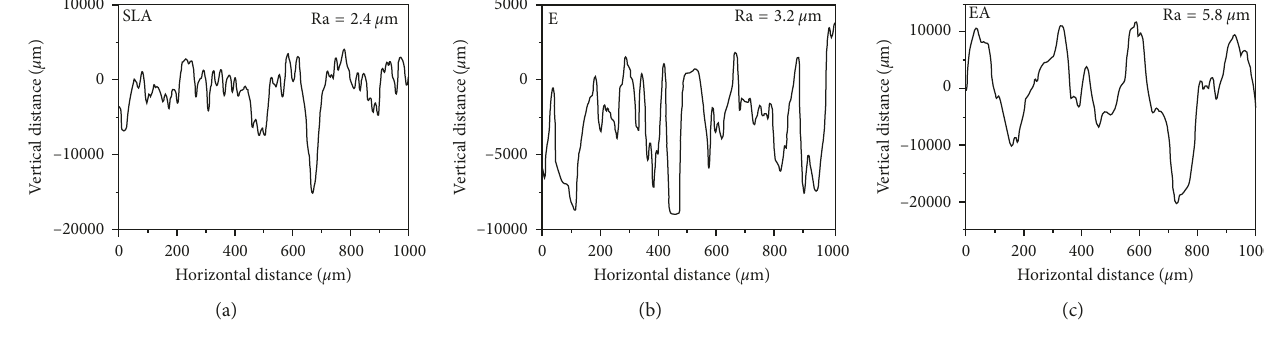
Figure 3: Surface roughness of SLA (a), E (b), and EA (c) surfaces.